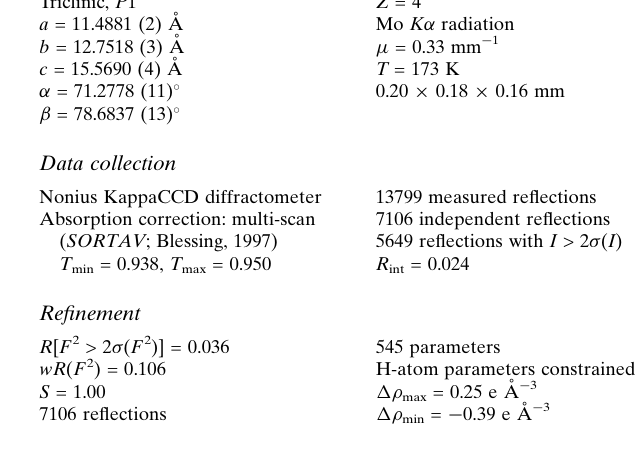
Related literature